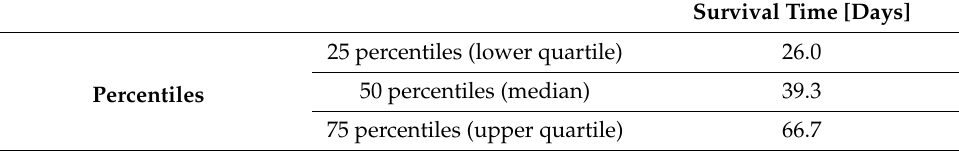
Table 6. Survival